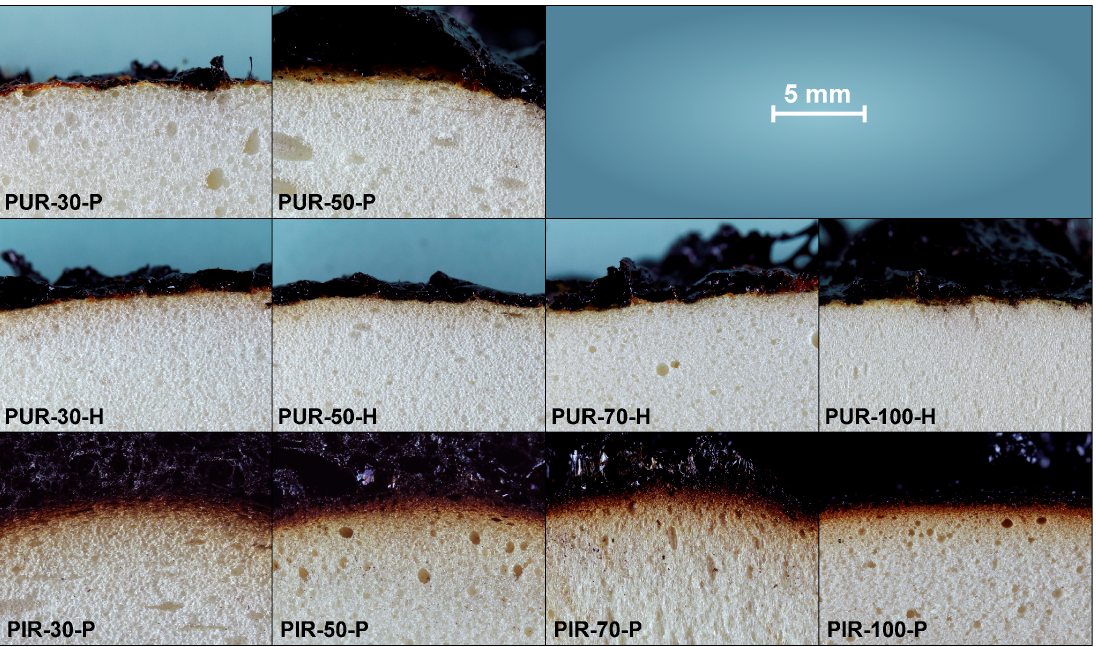
Figure 11. Macro photographs of cross sections of quenched samples.